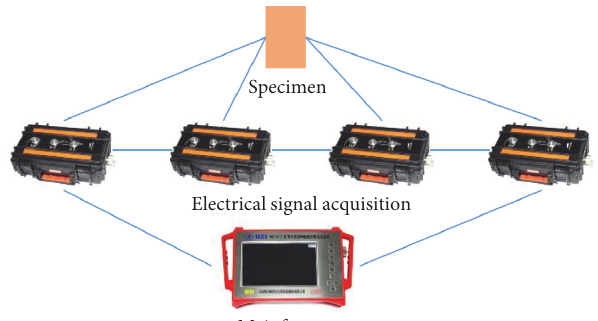
Figure 2: Direct current electrical monitor.